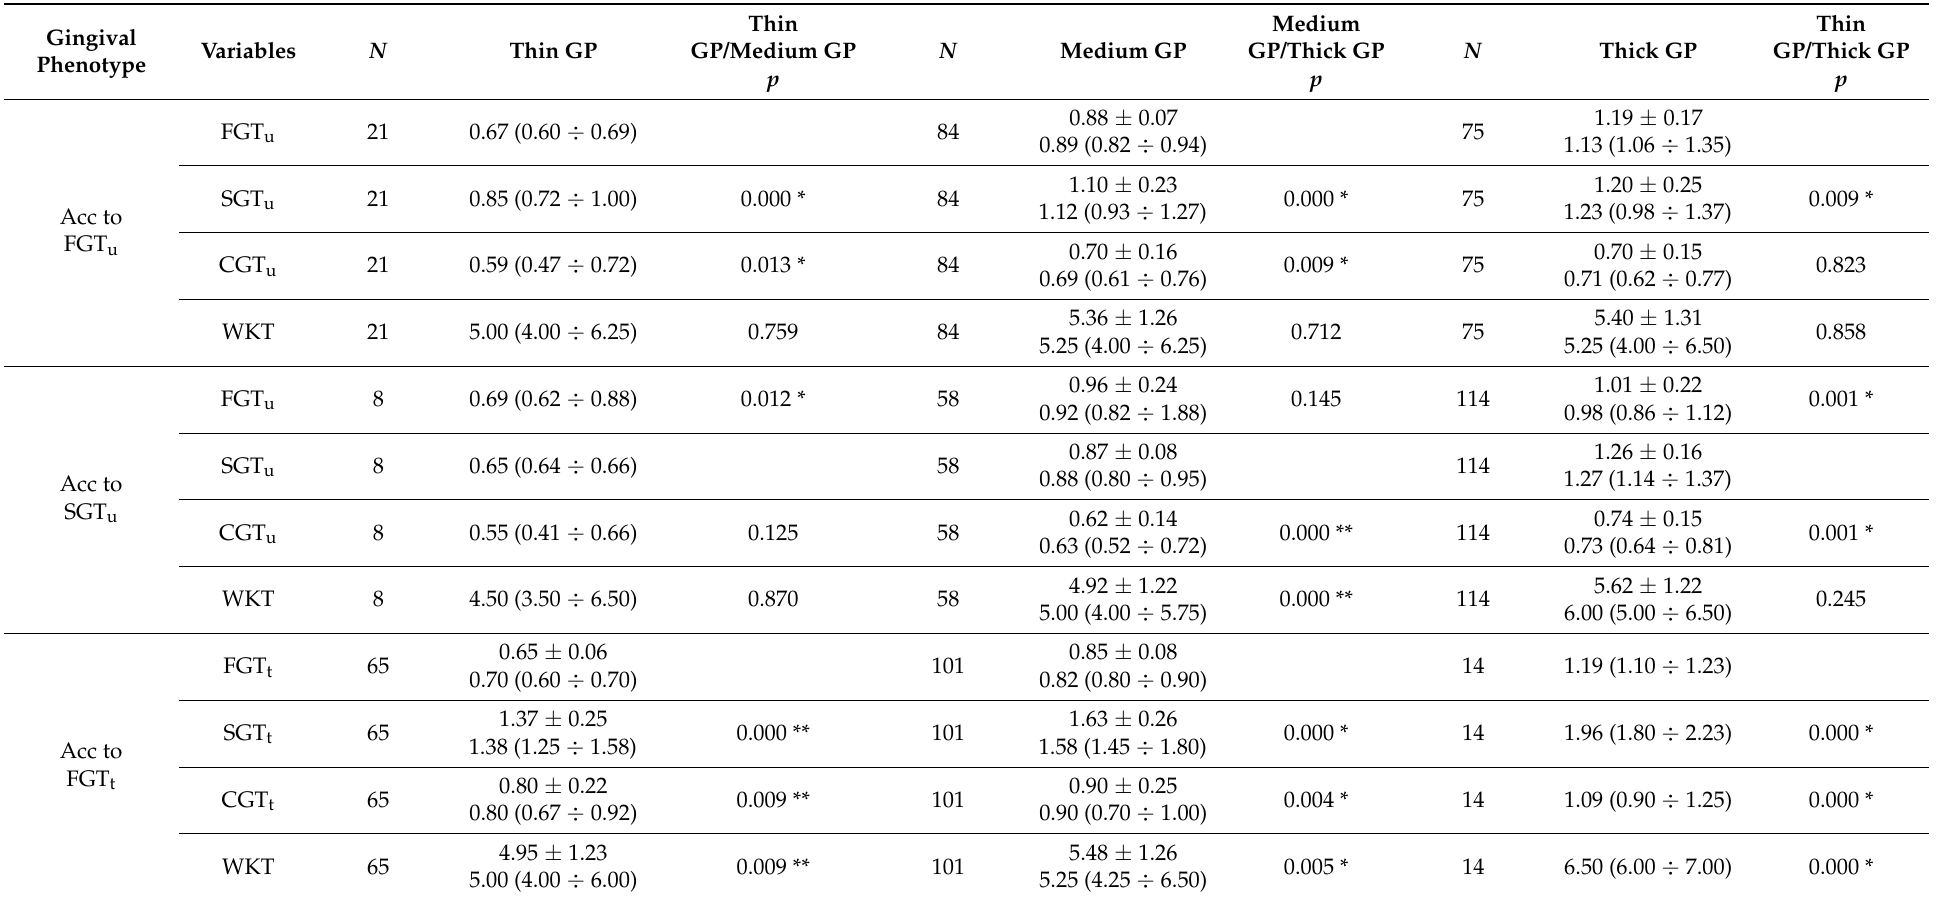
Table 6. Variables assessed in individual gingival phenotypes according to the criteria of dividing the mean values of FGT u , FGT t and SGT u in